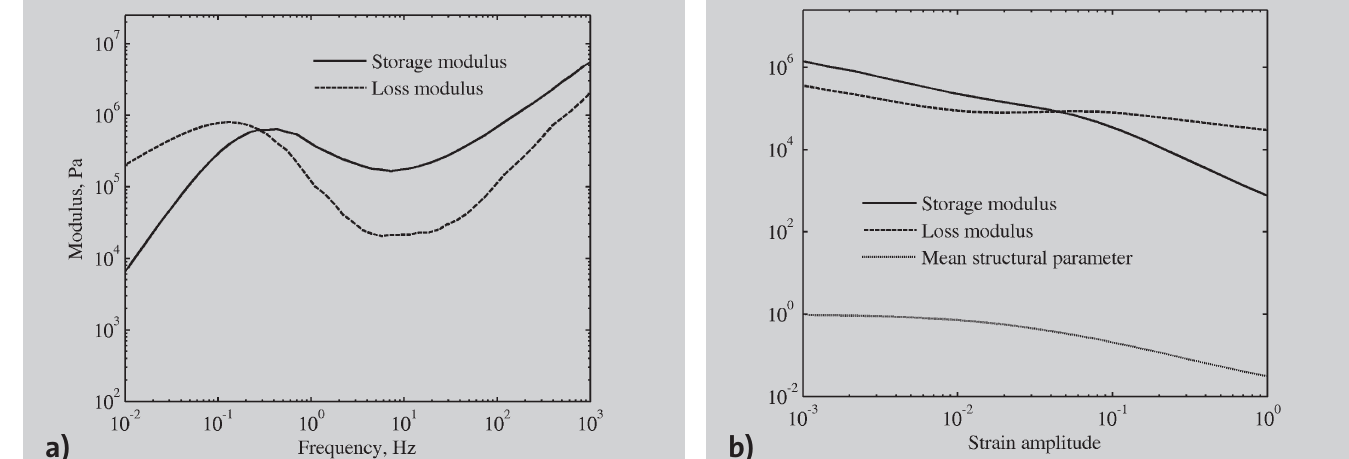
Figure 4: (a) Frequency dependence of the storage and loss moduli. (b) Variation of the mean structural parameter and moduli for different strain amplitudes (parameters for Asphalt 1, Table